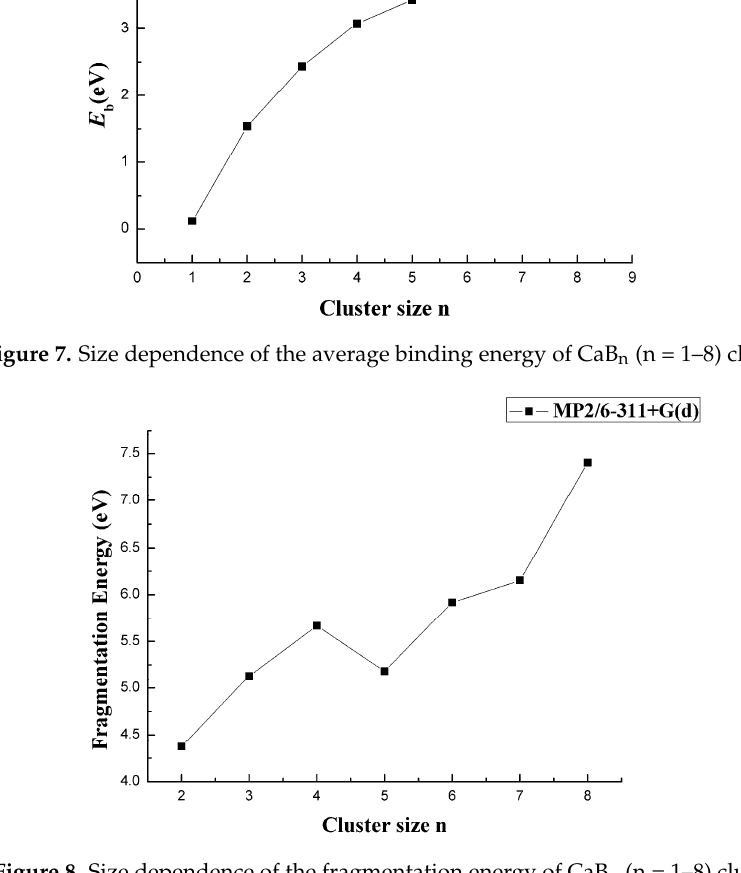
Figure 9. Size dependence of the second-order difference energy of CaB n (n = 1–8) clusters. The second-order difference in total energy is considered a very useful quantity that can reflect the relative cluster stability in the field of cluster physics [26]. From the MP2 result, the second-order difference energy followed a clear “odd-even oscillation” phenomenon for n = 3–7, as shown in Figure 9. When n was even, the value was at the peak, which indicated the higher stability of these clusters. The results were consistent with the information revealed in Figure 8. When n = 4, the second-order difference energy was the largest, which meant the CaB 4 was the most stable among CaB n (n = 3–7). 3.3. The Ability of Obtaining or Removing an Electron The ADE and AEA of the CaB n clusters were calculated to investigate the ability of the most stable CaB n clusters to remove or obtain an electron. A larger value of ADE meant that it was difficult for the cluster to remove an electron, and a larger value of AEA meant that it was easy to gain an